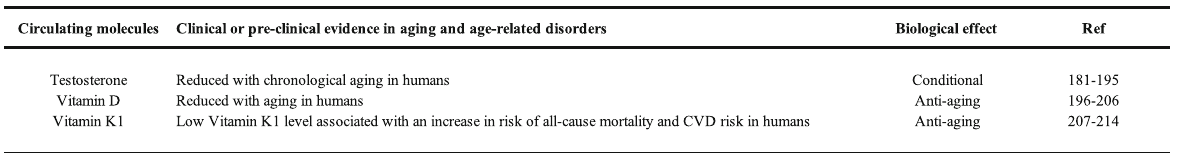
Table 2 The dynamics, clinical or pre-clinical evidence, and biological effect of circulating steroid hormone and vitamins in aging and age-related disorders